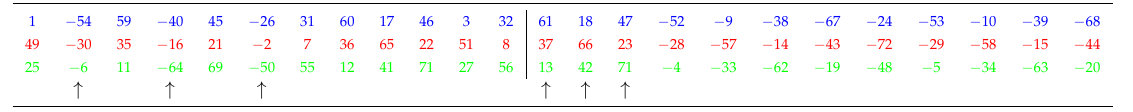
Figure 15. Double chording with a 3rd-order single-sided imbrication for N = 72, p = 5, m = 3 and q = 2 + 2 / 5 . ( a ) Star of slots and ( b ) winding scheme. Table 17. Double chording with a 3-rd order single-sided imbrication for N = 72, p = 5, m = 3 and q = 2 + 2 / 5 .